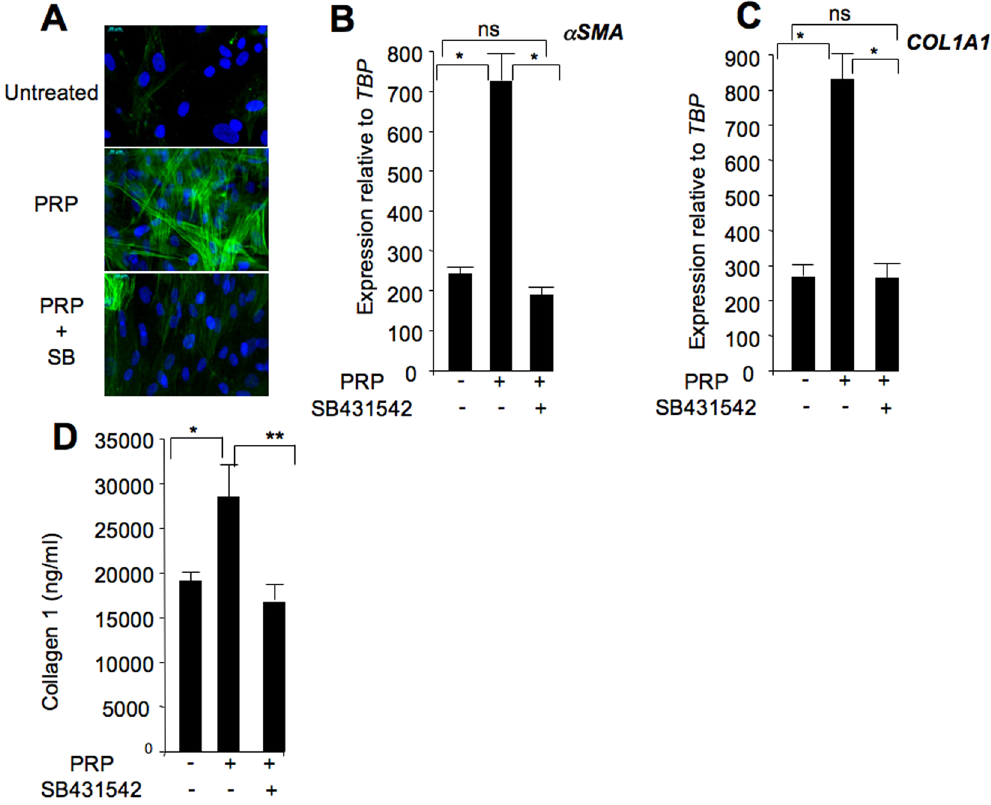
Figure 4. PRP-induced myofibrobast-like phenotype reversed by SB431542. ASCs were induced to undergo adipocyte differentiation for 11 days in the indicated conditions. ( A ) Generation of α SMA-expressing cells was revealed by immunoflorescence. ( B , C ) RNAs were prepared and expression of the indicated genes was analyzed by real-time PCR. Values are the mean ± SEM (n = 4 individual PRPs). ( D ) Media were collected and collagen type 1 secretion was quantified. Values are the mean ± SEM (n = 4 individual PRPs). * p < 0.05, ** p <